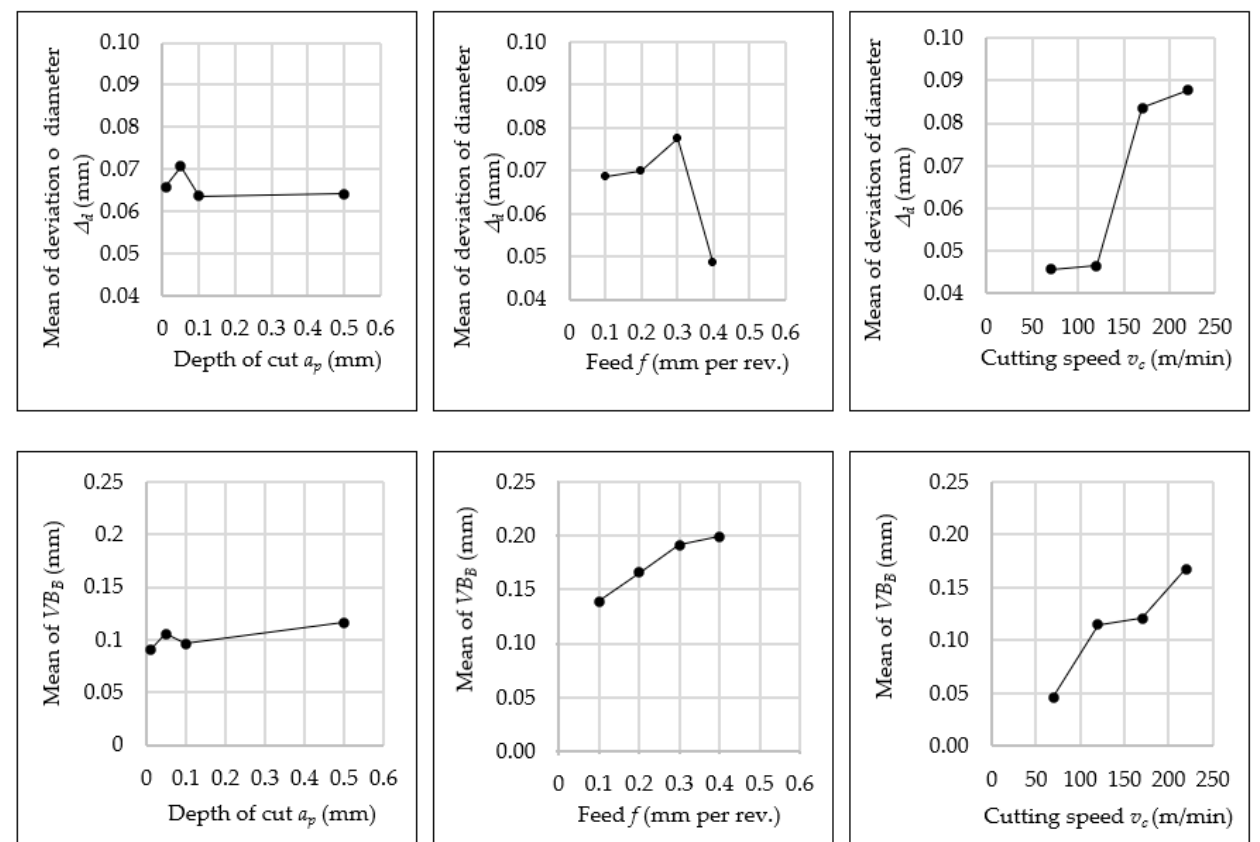
Figure 10. Main effect plot of diameter deviation Δ d and flank wear VB B.